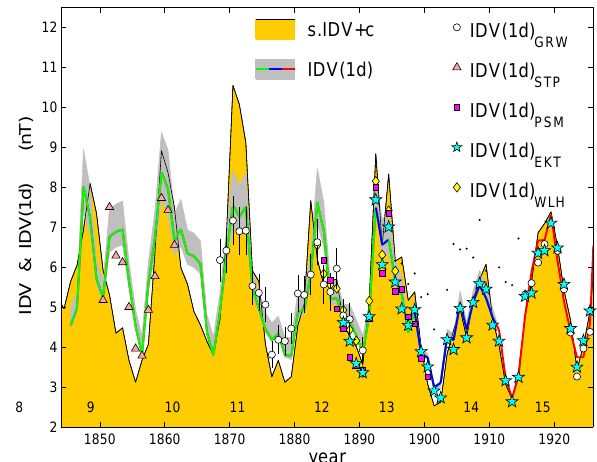
Fig. 14. Detail of Fig. 13 for before 1930. Annual means of the IDV(1d) composite are shown with data originating from ESK in red, NGK in blue and HLS in green, surrounded by a grey area showing the band of uncertainty that arises from the two regres- sion fits. The black line bounding the filled orange area is the IDV index of SC10, scaled using the regression for 1880–2013, as shown in Fig. 12. IDV(1d) derived from various early data sets are also shown: from St Petersburg, IDV(1d) SPE (pink triangles); from Ekaterinburg, IDV(1d) EKA (cyan stars); from Parc St Maur, IDV(1d) PSM (mauve squares); from Wilhelmshaven, IDV(1d) WLH (yellow diamonds); and from Greenwich, IDV(1d) GRW with σ H <30nT (white circles). The Greenwich values are compiled using the daily means of H that are uncorrected for temperature varia- tions, but then the annual IDV(1d) values are corrected (giving the shown uncertainty bands caused by the temperature effects). The small black dots are Greenwich data which have been cleaned to try to remove the instrumental fluctuations in H shown in Fig. 1, but which are not regarded as reliable because even after such cleaning σ H ≥ 30nT. Solar cycle numbers are shown across the base of the